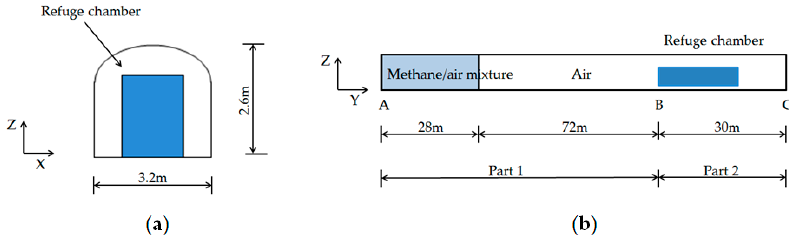
Figure 2. The cross ‐ section and longitudinal section area of the tunnel. ( a ) Cross ‐ section of the tunnel; Figure 2. The cross-section and longitudinal section area of the tunnel. ( a ) Cross-section of the tunnel; ( b ) Longitudinal section area of the tunnel. ( b ) Longitudinal section area of the